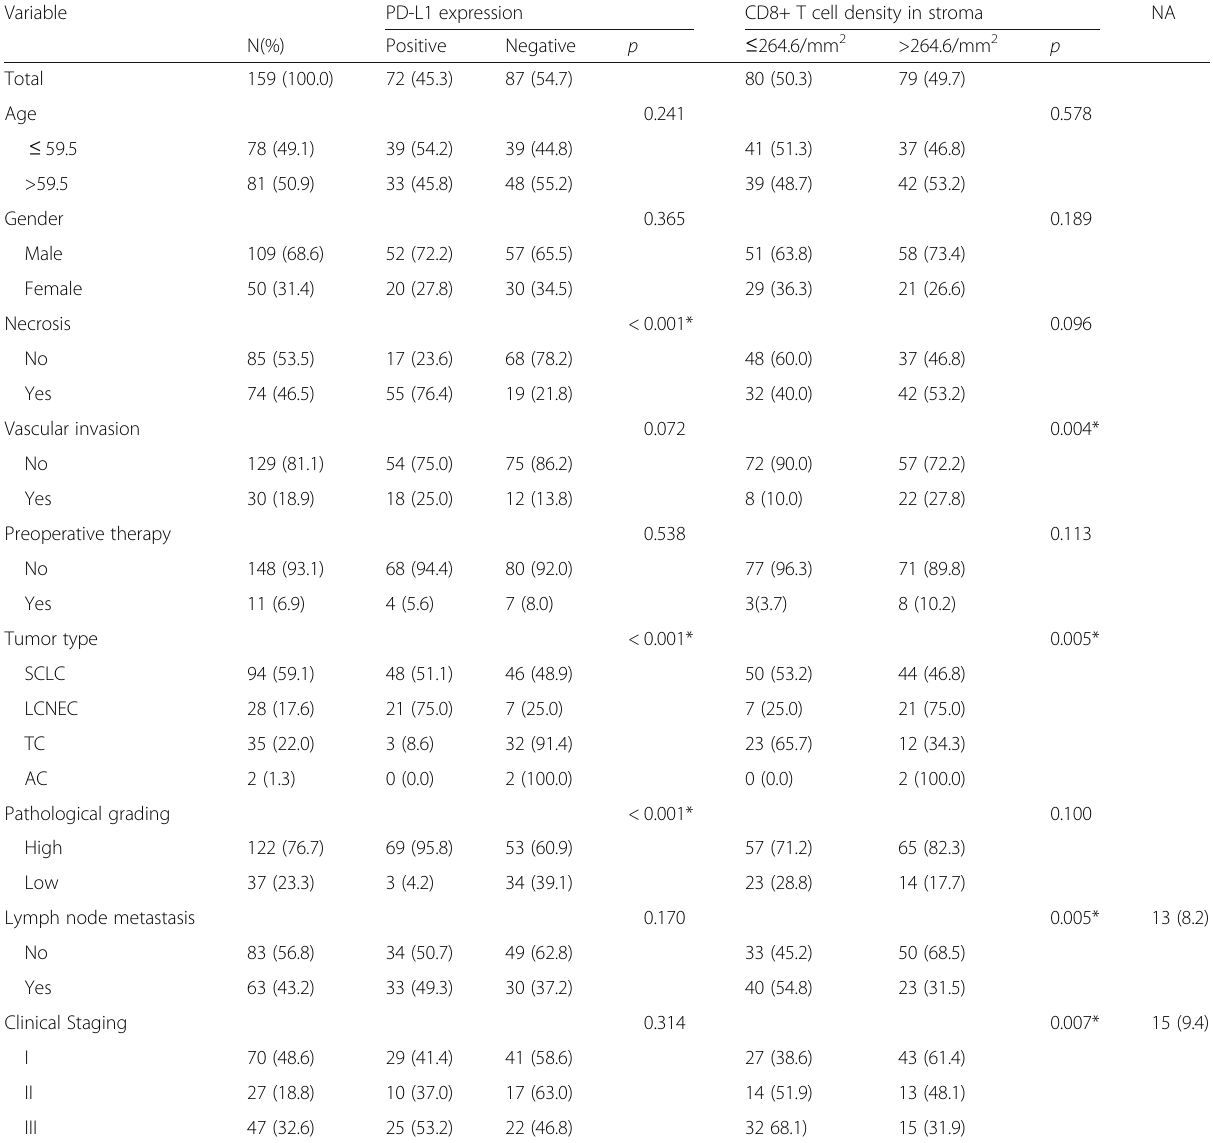
Table 2 The association between PD-L1 expression, CD8+ T cell infiltration and clinicopathologic parameters in